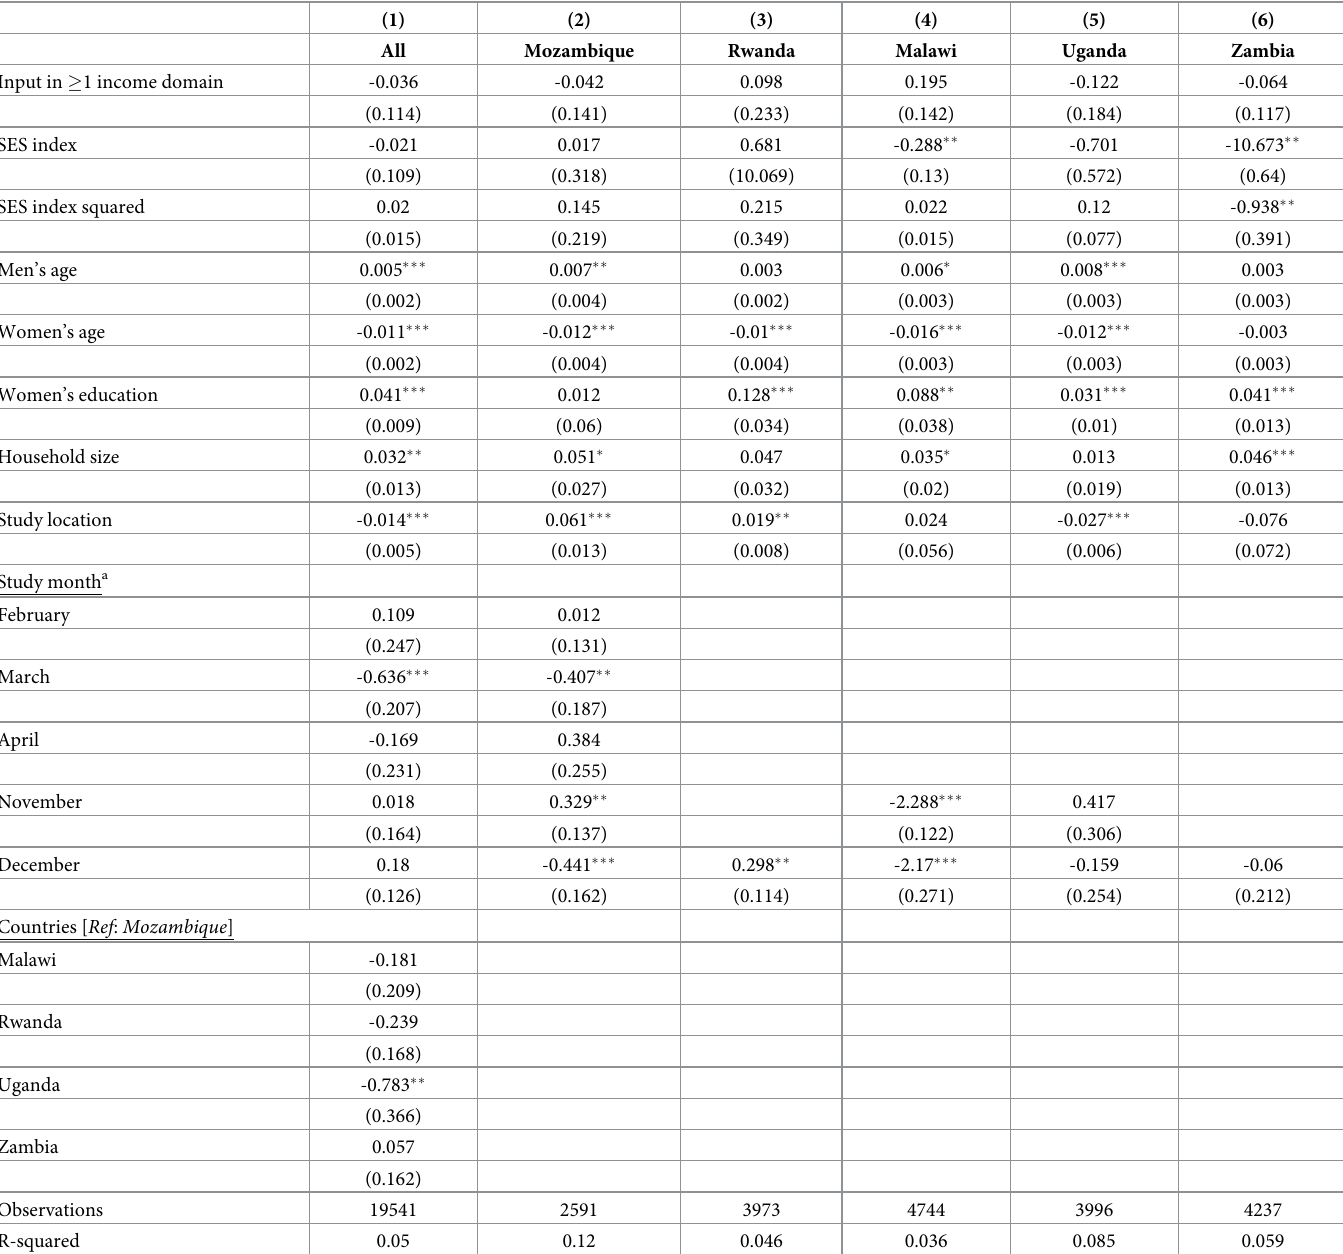
Table 10. OLS regression results for WDDS–regression results for WDDS–income domain (Input in at least 1 income